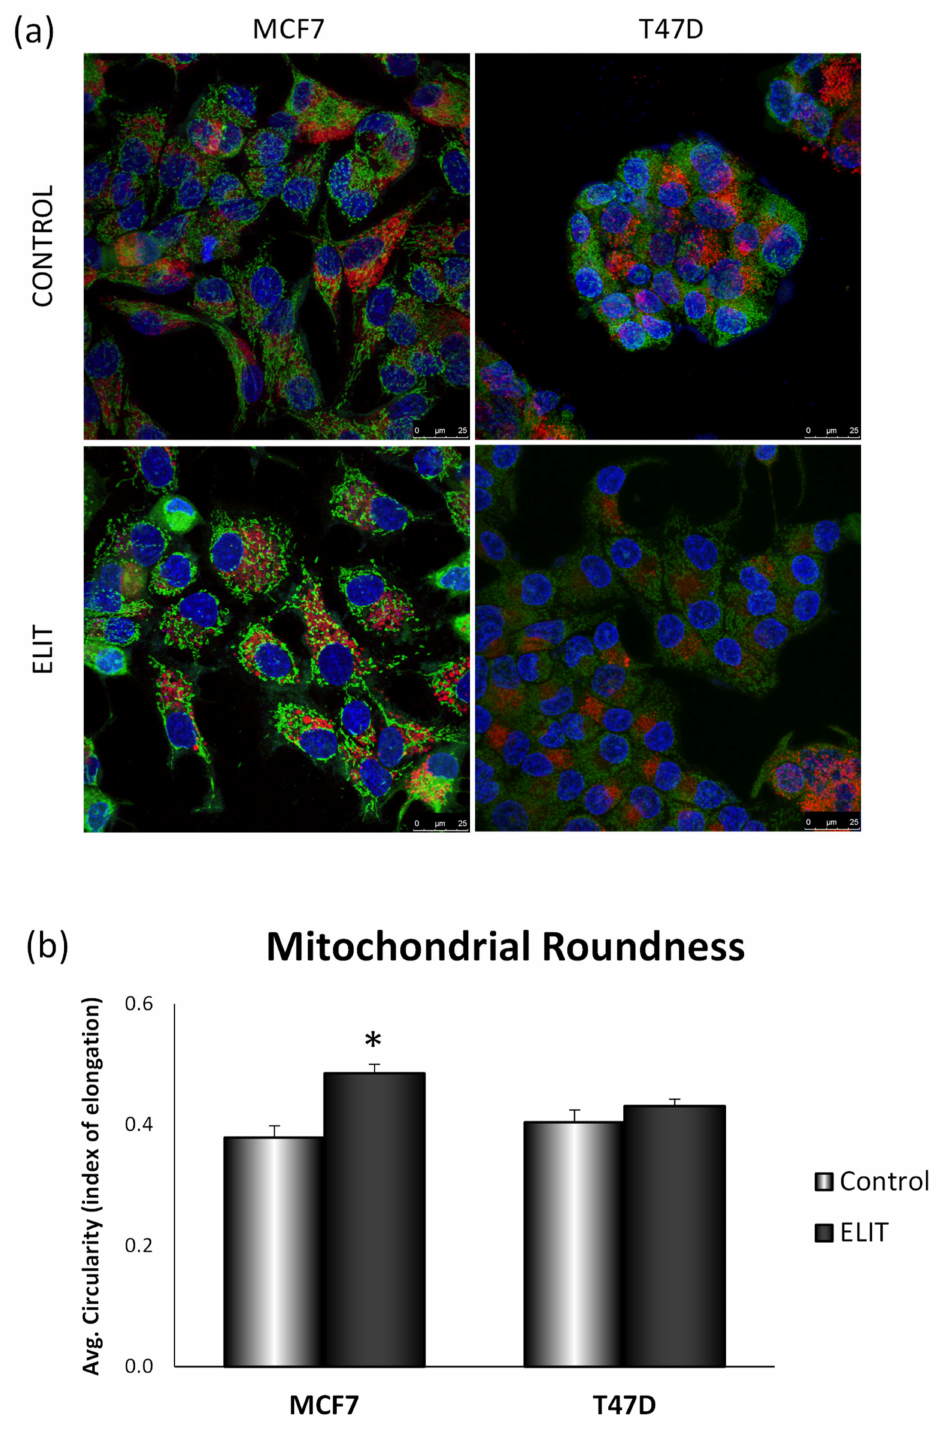
Figure 6. ELIT treatment induces mitochondrial networking changes in the MCF7 cell line. ( a ) Breast cancer cell lines MCF7 and T47D were treated with ELIT for 24 h followed by co-incubation with MTG, LTR, and Hoechst 33342. The fluorescence was monitored with a Leica Confocal Microscope using 63 × oil 147 N.A. objective lens. Scale bar 25 µ m. ( b ) Mitochondrial Roundness was analyzed with ImageJ Software. Breast cancer cells were incubated for 24 h with vehicle (DMSO) or ELIT. Data are represented as an index of elongation, set at one when a perfect circle. Data represent means ± SEM ( n = 6). * Statistically significant difference between treated and vehicle-treated cells (Student’s t -test, * p <